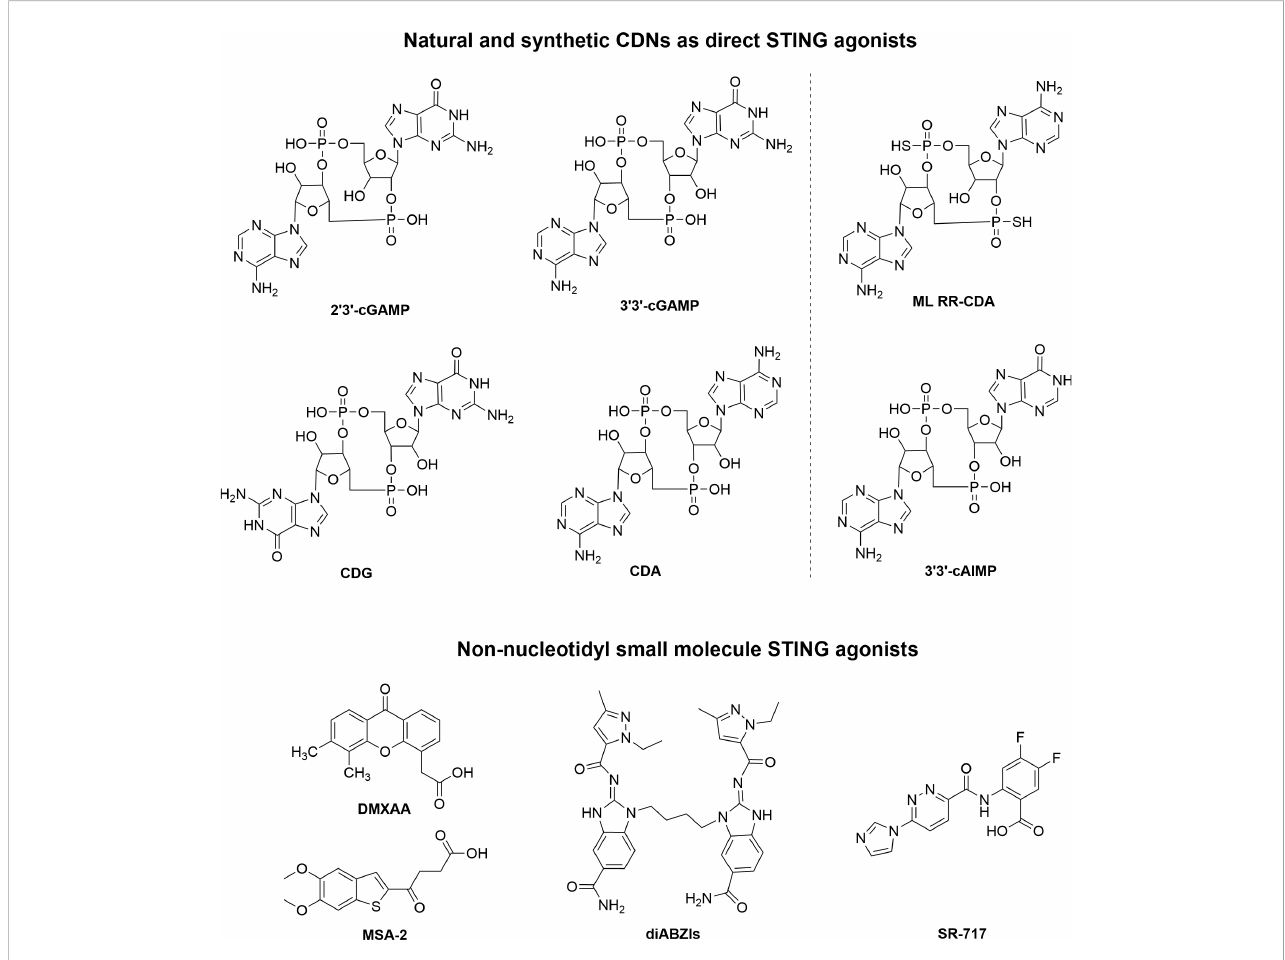
FIGURE 2 The chemical structure of representative nucleotide and non-nucleotidyl STING